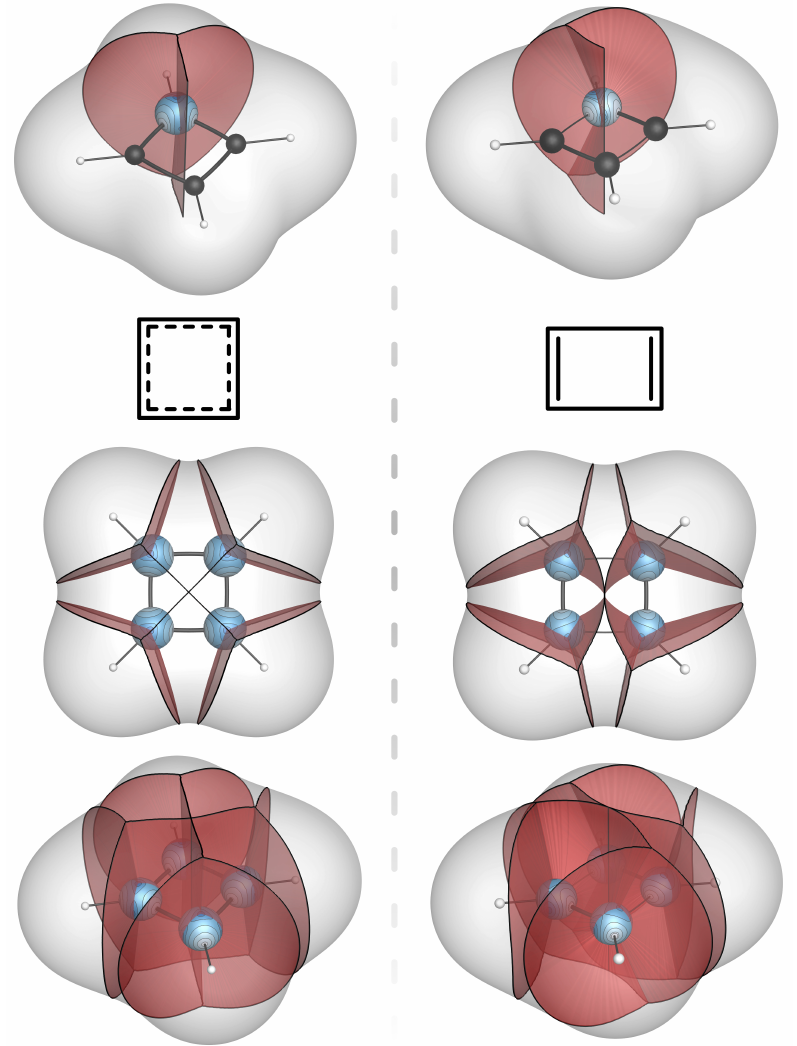
Figure 4. Bond-wedge and bond-bundle surfaces in cyclobutadiene in square-planer and rectangular geometries, intersecting C-atom-centered reference spheres with mapped contours of P . Bond-bundle surfaces are truncated at the ρ = 0.001